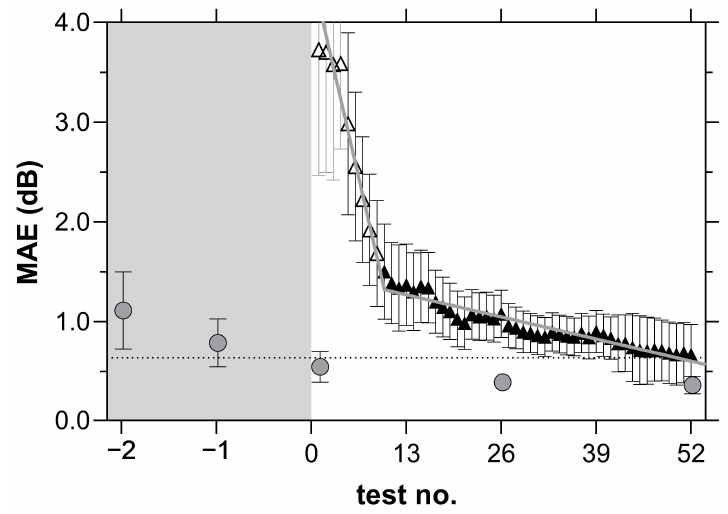
Figure 3. Mean absolute error (MAE, dB) from the median MD value calculated from the average of 5 HFA tests performed in-clinic (filled circles) and the average of 52 MRFh tests performed at home (filled triangles) in n = 20 glaucoma participants. The first 9 unfilled triangles represent a period of learning with high deviations from the median value. Error bars represent SEM. The grey curve represents a two-line fit of the MRFh data which assumes a shallower slope after 10 tests. The grey zone on the left indicates the period preceding VFTM where participants were required to have a minimum of 2 reliable HFA examinations to enable guided progression trend analysis.